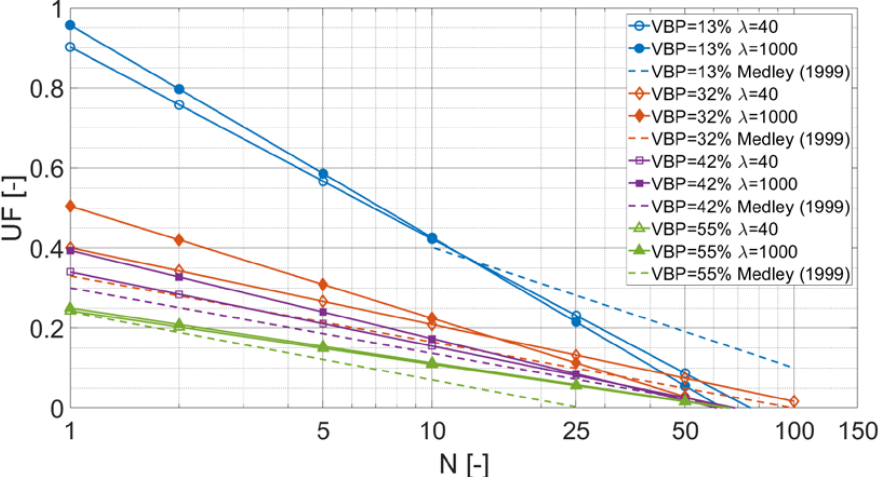
Figure 7. Influence of λ (maximum number of randomizations) on the uncertainty in the VBP esti- mate from LBPs, as a function of the total sampling length, N. Dashed trend lines from Medley [49] chart (Figure 2 b) shown for comparison with λ = 40 trend lines from this study. (Note: symbols on trend lines are line markers and not data points).